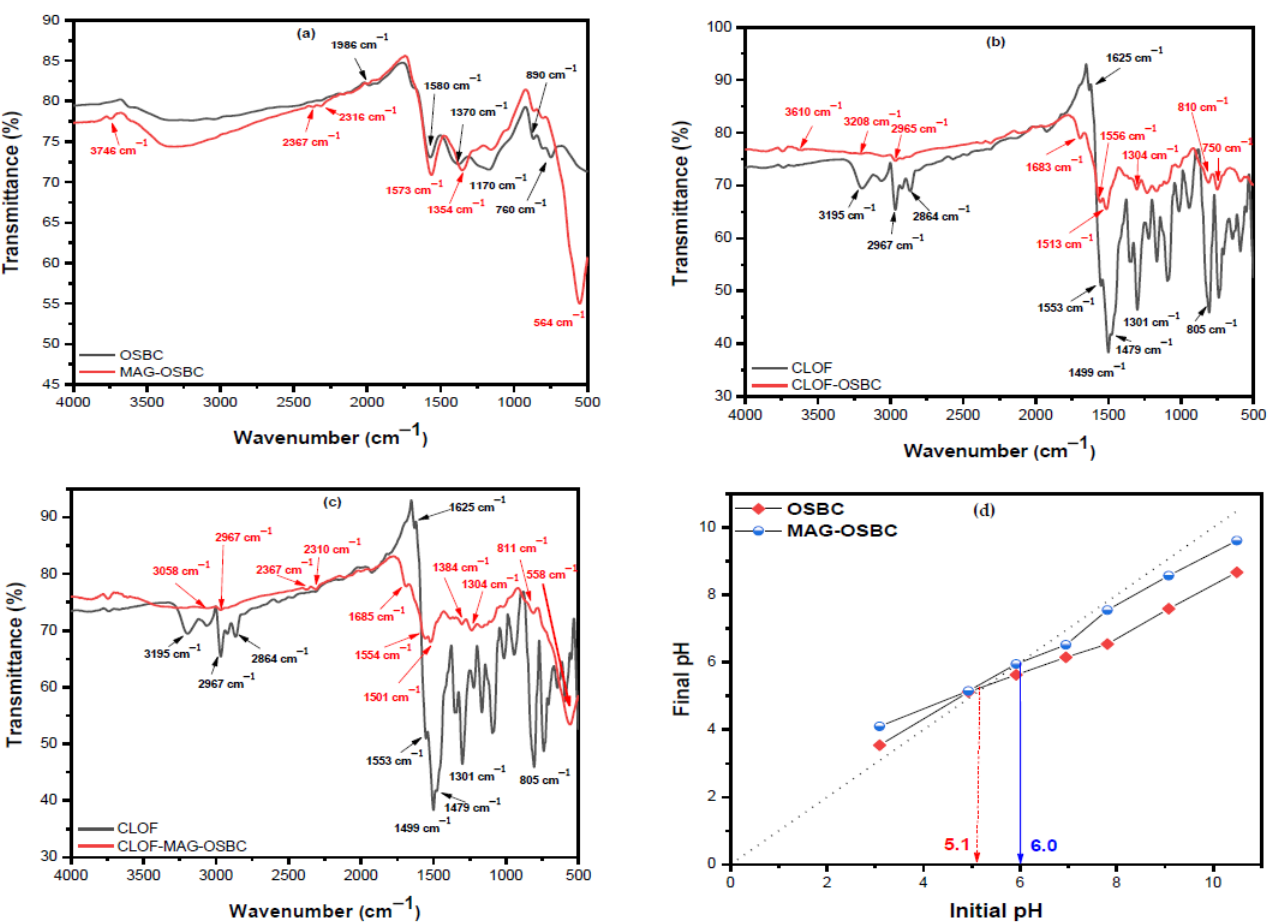
Figure 2. FT-IR spectra of OSBC and MAG–OSBC ( a ) before adsorption, ( b ) free CLOF and OSBC after adsorption, ( c ) free CLOF and MAG–OSBC after adsorption, ( d ) point-of-zero-charge (pH PZC ) for both